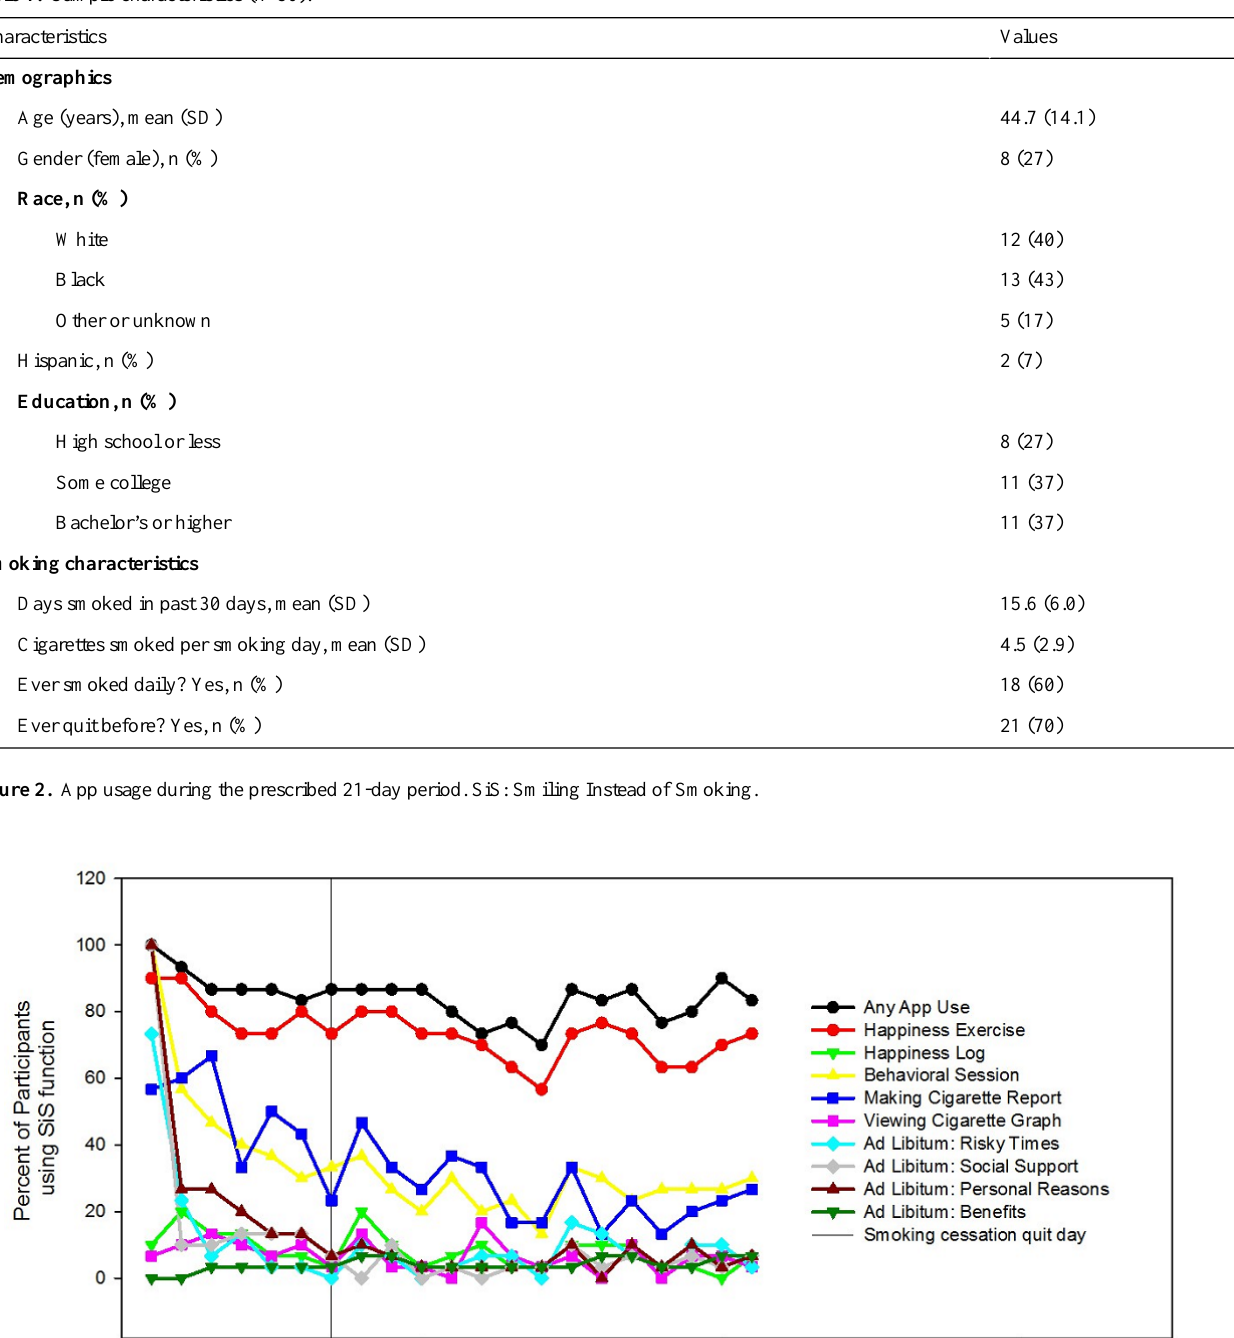
Table 1. Sample characteristics (n=30).